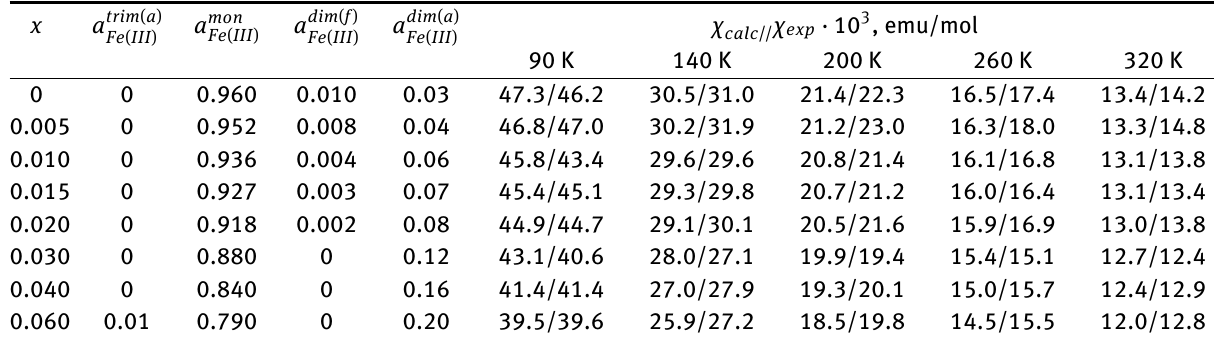
Table 1: The results of calculating the distribution of iron atoms in the solid solutions Bi 2 Mg 1− x Fe x Nb 2 O 9+ δ x